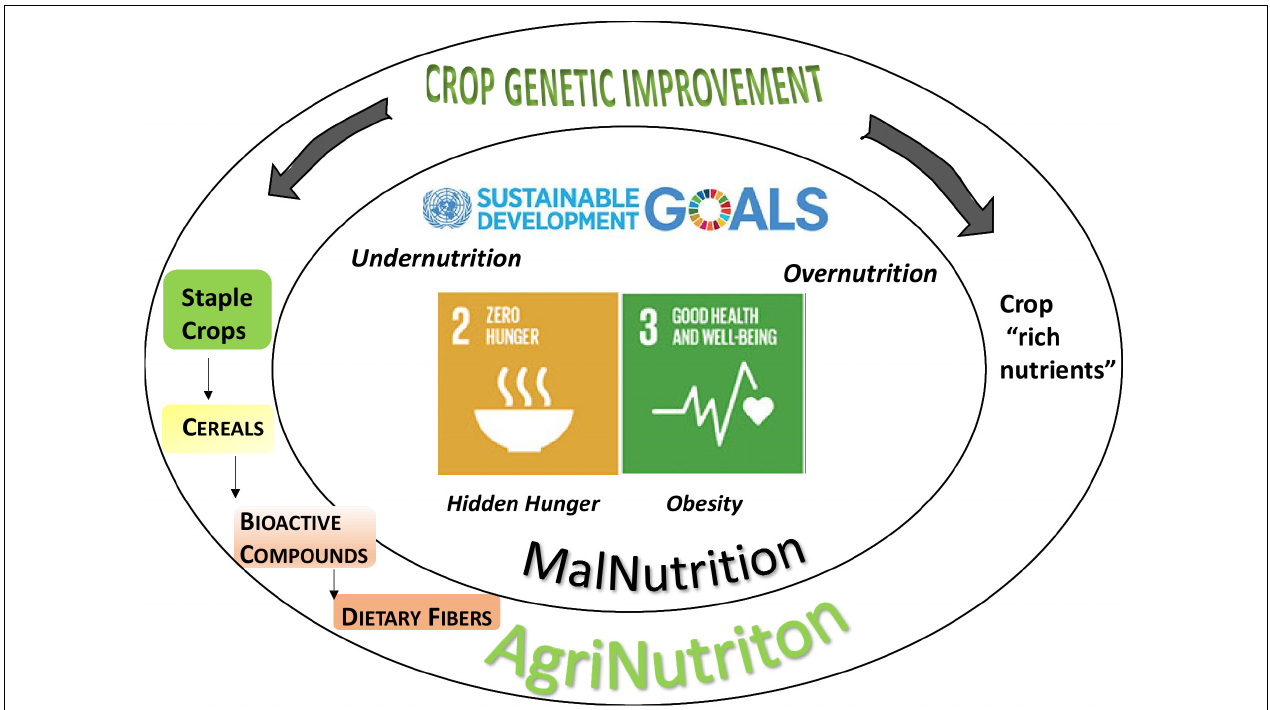
FIGURE 1 | The role of cereals in the fight against malnutrition. The widespread consumption of cereals makes them ideal to deliver health benefits encountering the ask of the Sustainable Development Goals (SDGs) 2 and 3 for Zero Hunger. Dietary fibers are bioactive compounds playing an important role in human health: breeding to increase their content in cereal grains is a promising approach to malnutrition issue; in comparison to “crops rich nutrient,” cereals offer a more effective delivery in the